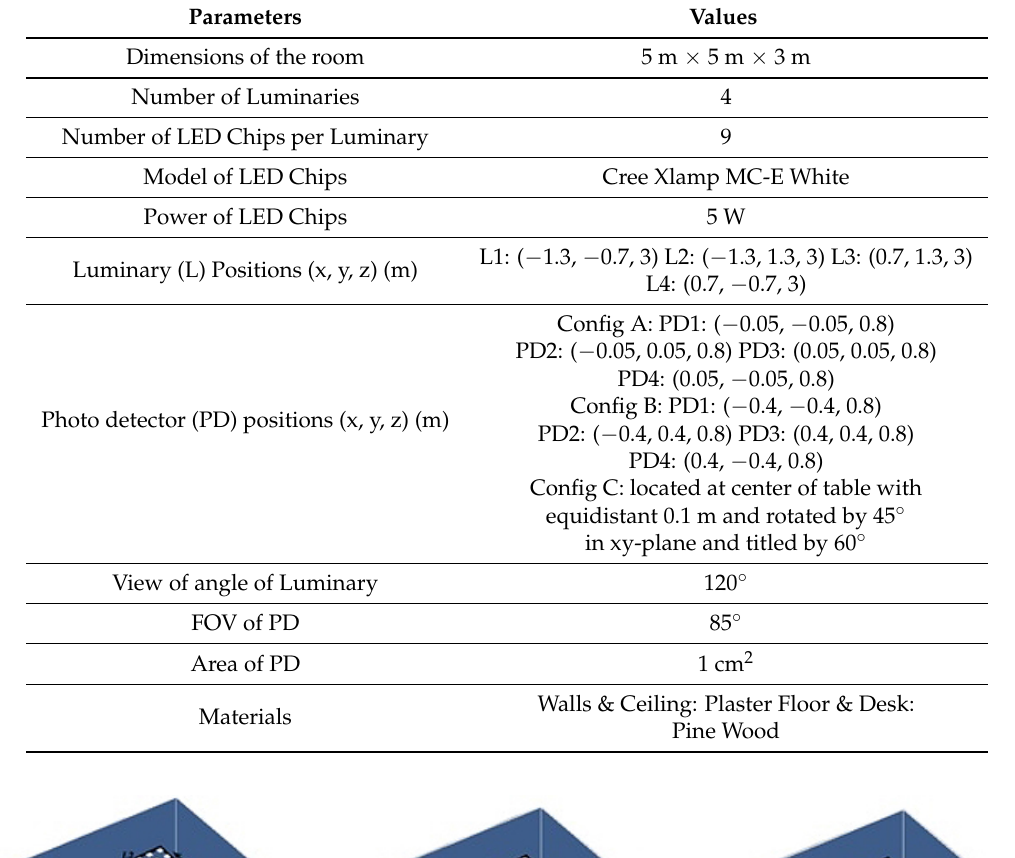
Table 3. The physical VLC channel parameters [31].